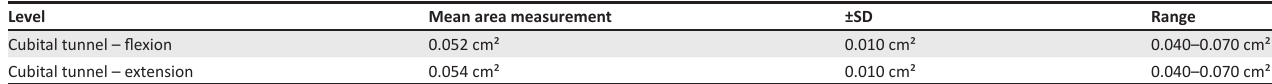
TABLE 4: Comparison of mean cubital tunnel cross-sectional area measurements between flexion and extension in asymptomatic